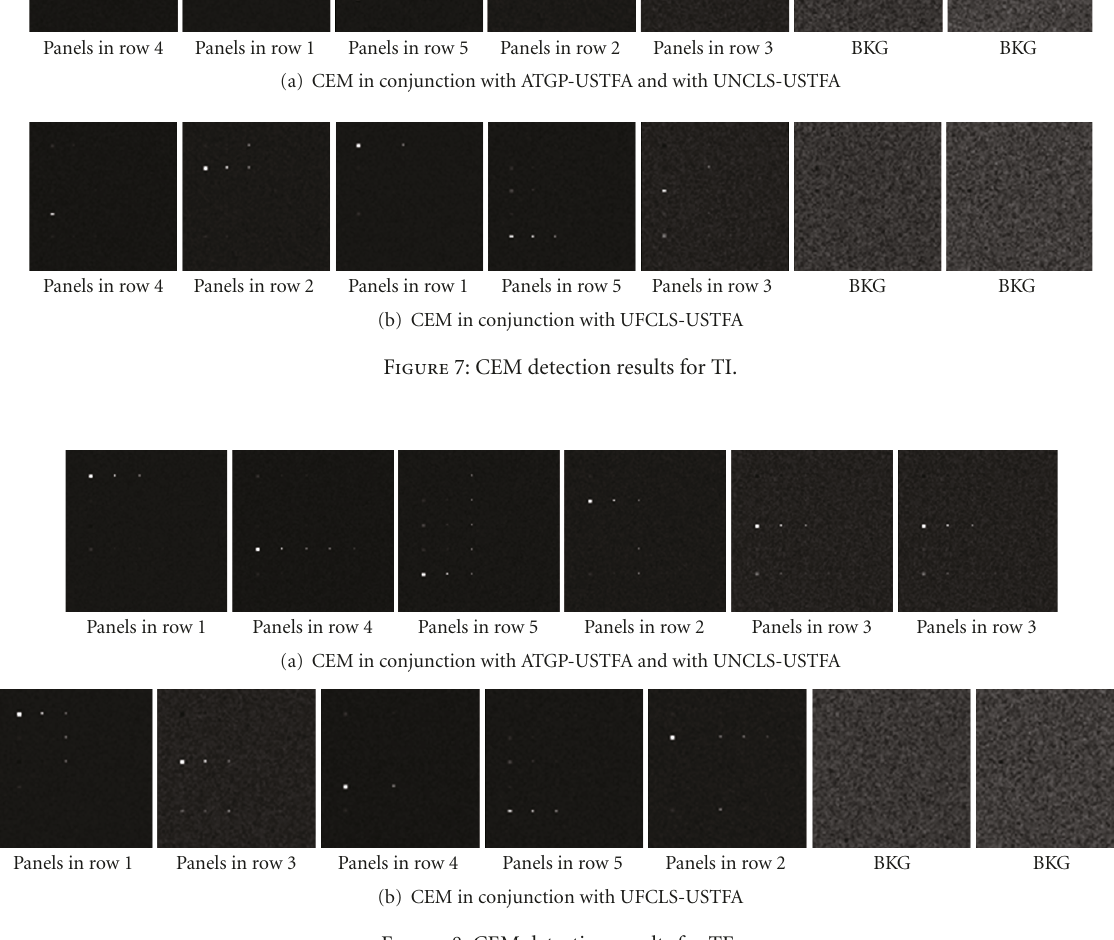
Figure 8: CEM detection results for